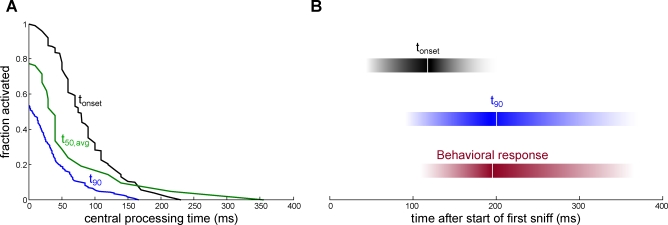
Dynamics of Glomerular Activation Relative to Odorant Response Times(A) Plot of the fraction of glomeruli or trials available to contribute to odor coding as a function of central processing time. Three response parameters are plotted: response onset (t
onset), near-maximal activation (t
90), and half-maximal activation of the aggregate response for one trial (t
50,avg). Each plot is derived from the cumulative probability distribution of its processing time (see Figure 5), truncating values that occur after the behavioral response has begun (which would give a negative central processing time). The t
onset and t
90 plots are pooled across all glomeruli, whereas the t
50,avg plot is on a per trial basis. See Results for further explanation.(B) Schematic summarizing the dynamics of neural activity and behavioral responses after the first inhalation of a novel odorant: t
onset, time to the earliest arrival of receptor input at the olfactory bulb; t
90, time to 90% signal amplitude for the optical signal in all glomeruli; behavioral response, time to the next inhalation for novel-odorant trials. Solid bars are representations of the probability of occurrence for each parameter. Darker color indicates increased probability; these probability density functions were estimated by fitting Gaussian distributions to the data in Figures 2C, 5A, and 5C. The median is indicated by the white line in the center of each bar.